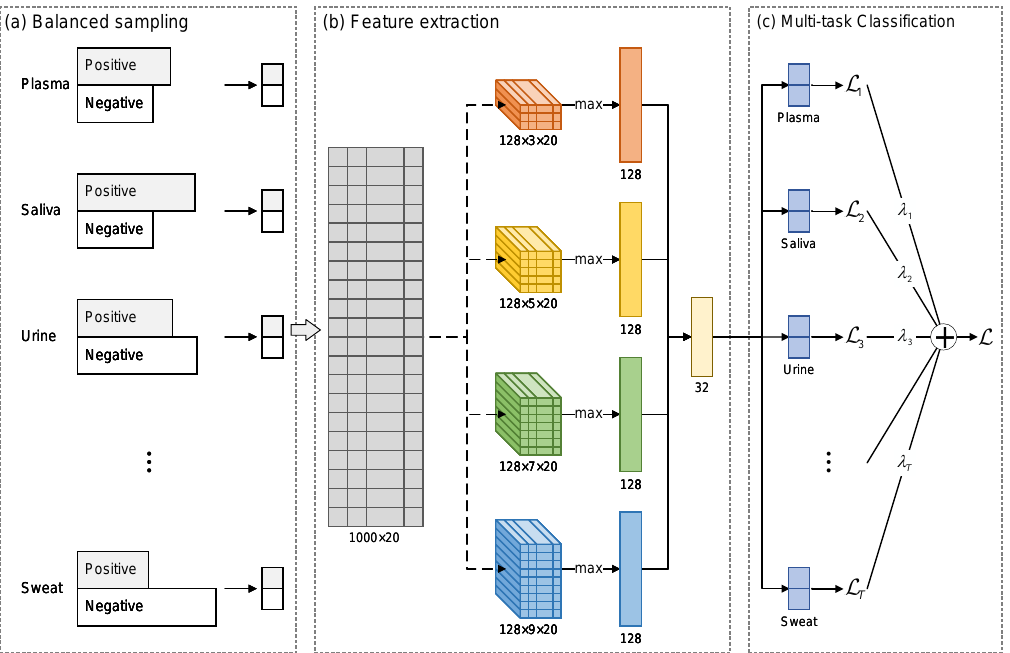
Figure 1. The architecture of MultiSec to discover secreted proteins by sequence: ( a ) the balanced sampling generates balanced data for each fluid; ( b ) feature extraction adapts four convolution- pooling operations and a fully-connected layer; ( c ) the multi-task classification contains 17 output layers to calculate 17 human body fluids